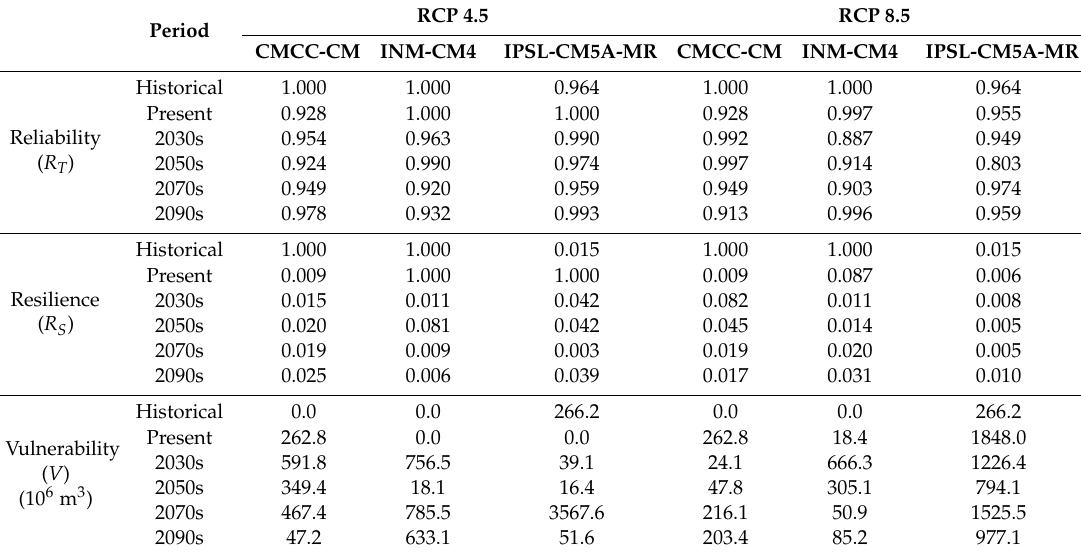
Table 7. The evaluation results of the Boryeong Dam water supply safety for 6 future dry